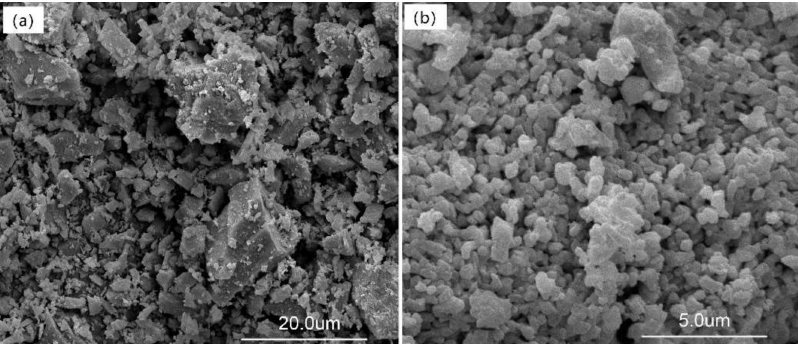
Figure 6. SEM images: ( a ) K-feldspar and ( b ) lime.